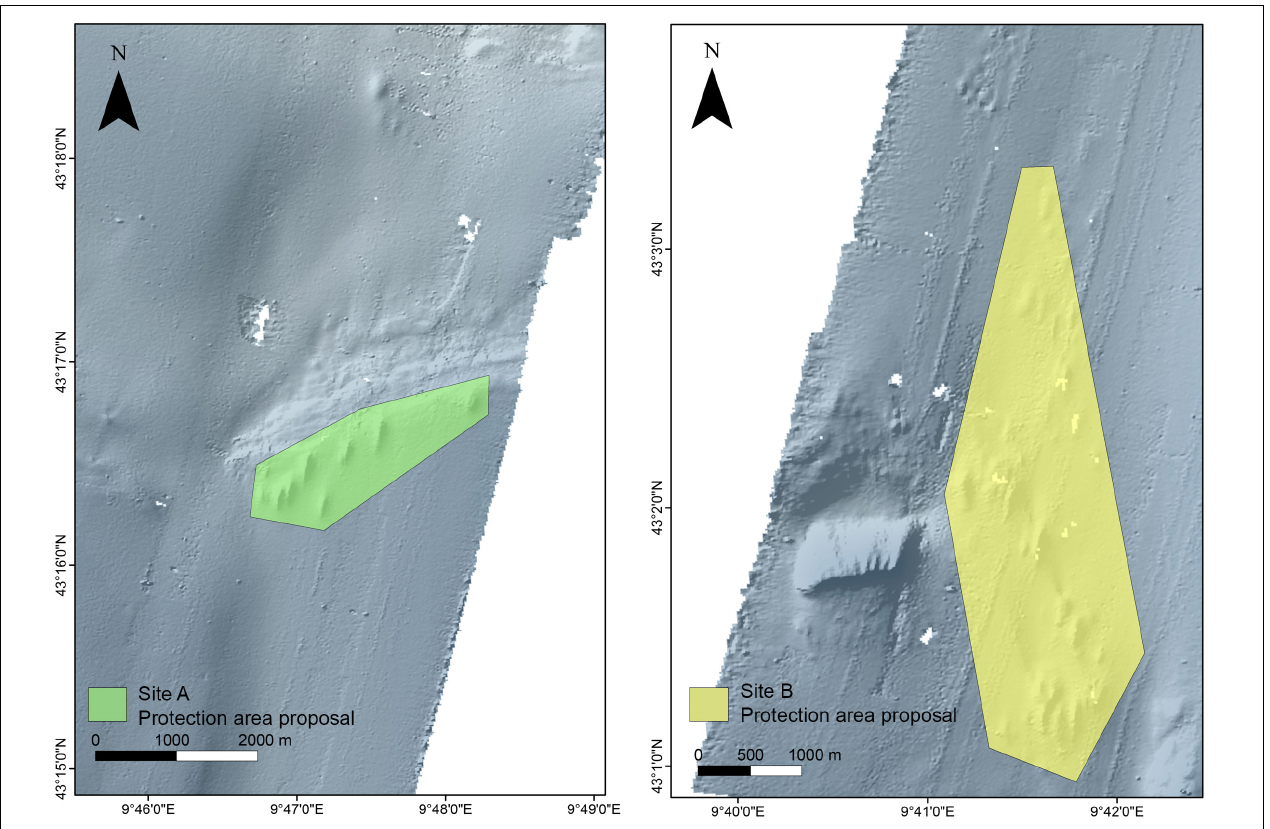
FIGURE 9 | Map showing the areas proposed for protection of cold-water coral (CWC) mounds. Protection area for Site A (left) has an extension of 1.47 km 2 , while Site B area (right) extends for 3.86 km 2 .